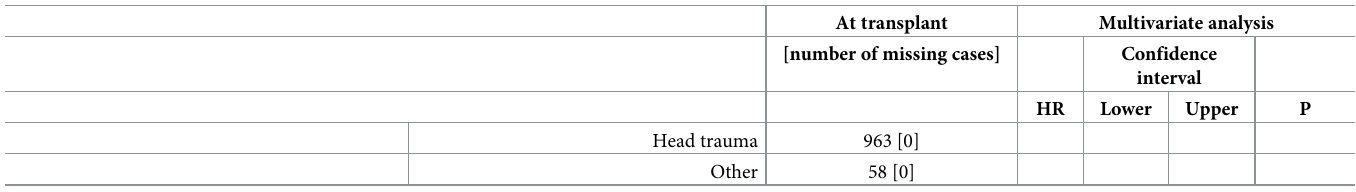
risk models (such as Cox proportional hazard).